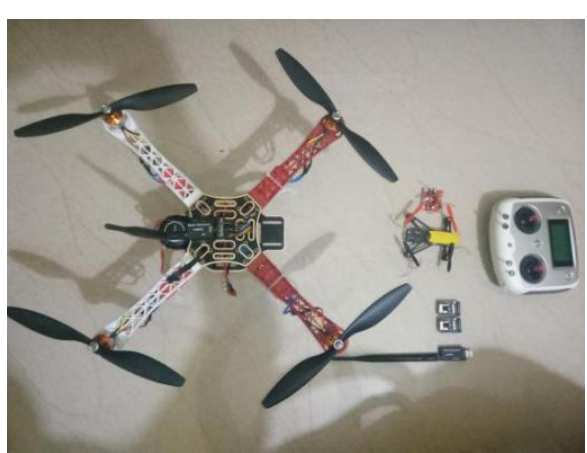
Fig.3 .initial prototype model UAV, MAV (on